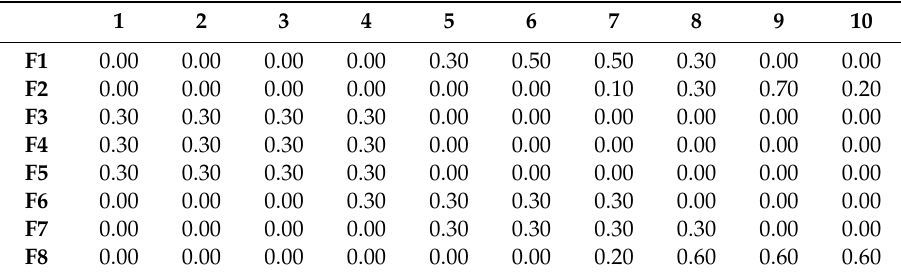
Table 10. Expert #2 favorable evidence degree versus VMEA weights.